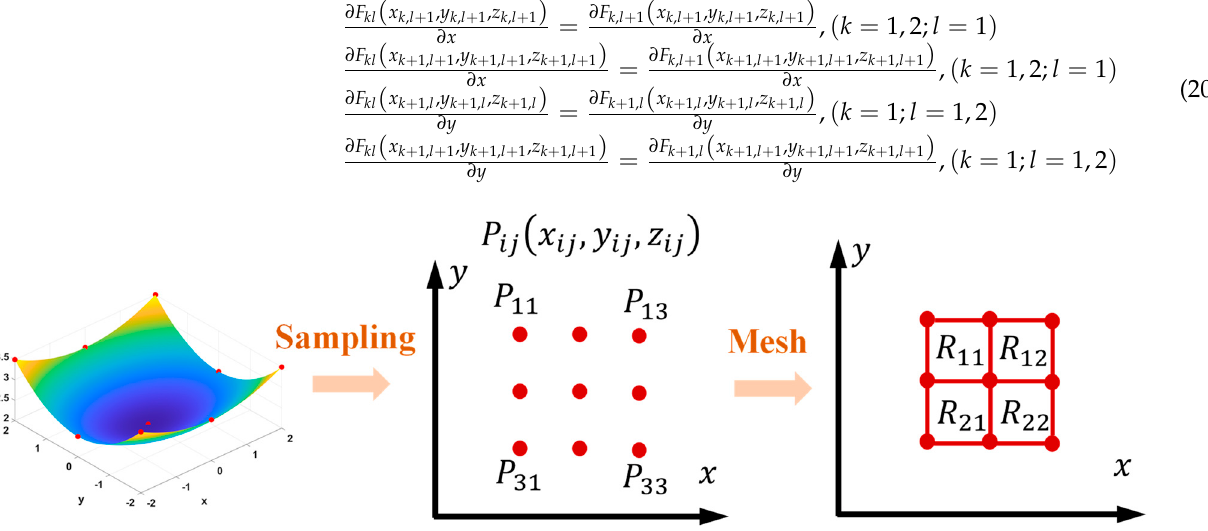
Figure 2. Preprocessing of biquadratic spline interpolation.